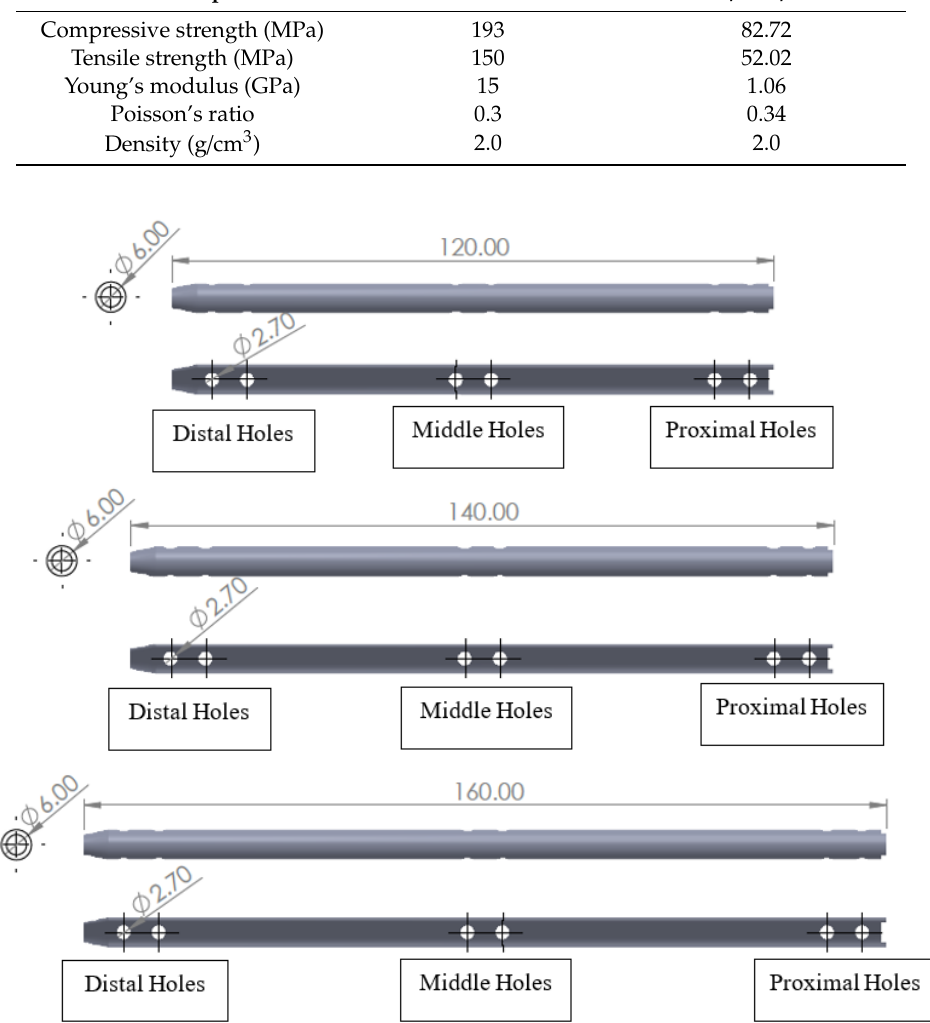
Figure 4. The holes ’ positions and three lengths of the composite interlocking nail.